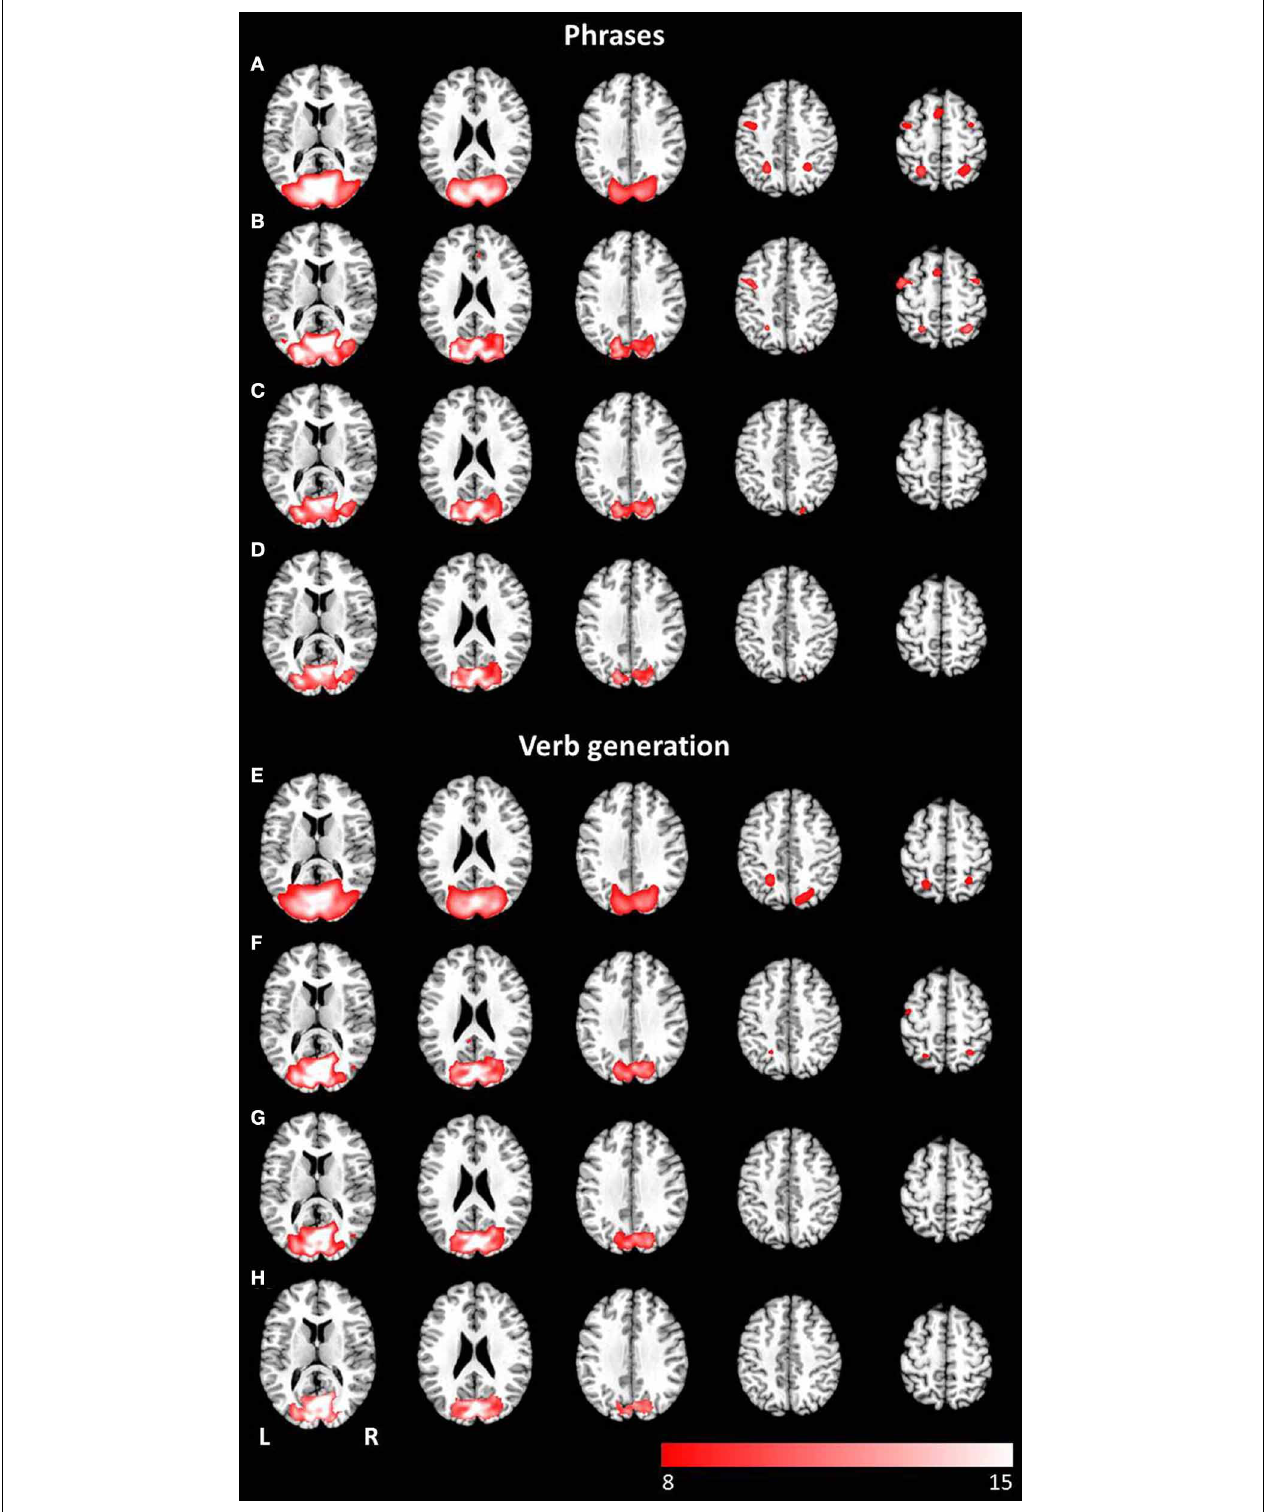
FIGURE 5 | Axial mean anatomical images overlaid with the attention-shift network, resulting from combined group ICA including auditory and visual stimulus presentation ( p < 0 . 05, FWE-corrected). This network was determined for (A) the phrases task and (E) the verb generation task. The comparison of modality specific differences shows